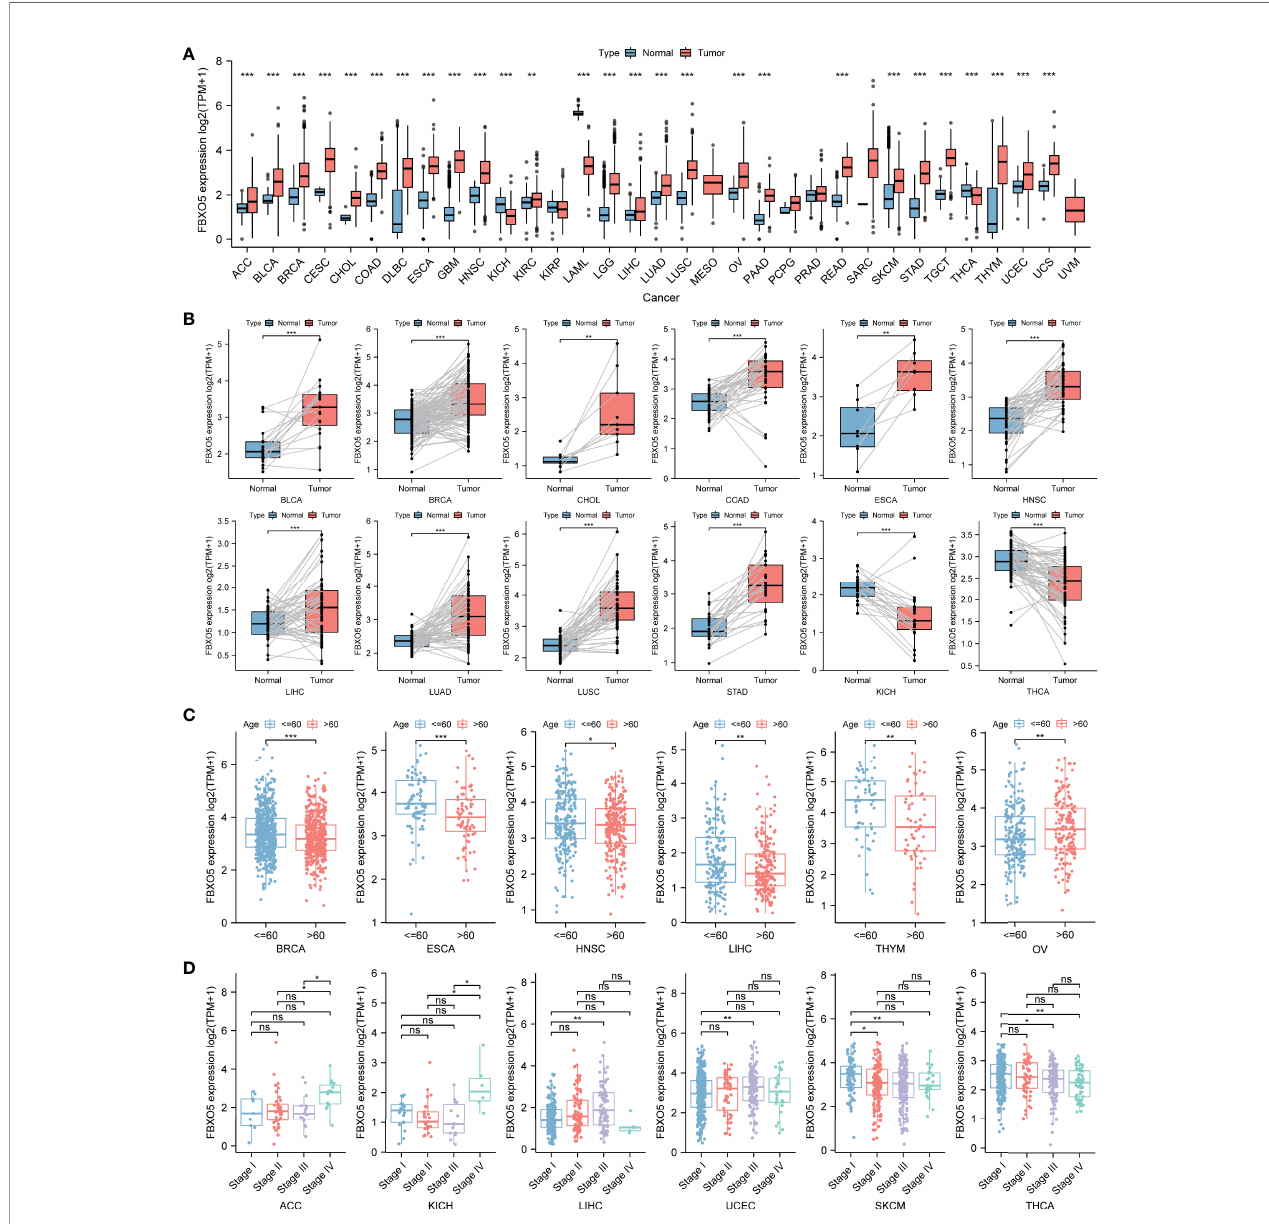
FIGURE 3 | Differential analysis of FBXO5 expression in different kinds of tumors. (A) FBXO5 expression differences in tumor tissues from TCGA database compared with normal tissues from GTEx and TCGA databases. (B) Paired differential analysis of FBXO5 expression in matched tumor and normal samples from TCGA. (C) Differential analysis of FBXO5 expression based on cancer patient age in TCGA. (D) Differential analysis of FBXO5 expression based on tumor pathological stages in TCGA. * p -value < 0.05, ** p -value < 0.01, and *** p -value < 0.001. “ ns ” indicated no signi fi